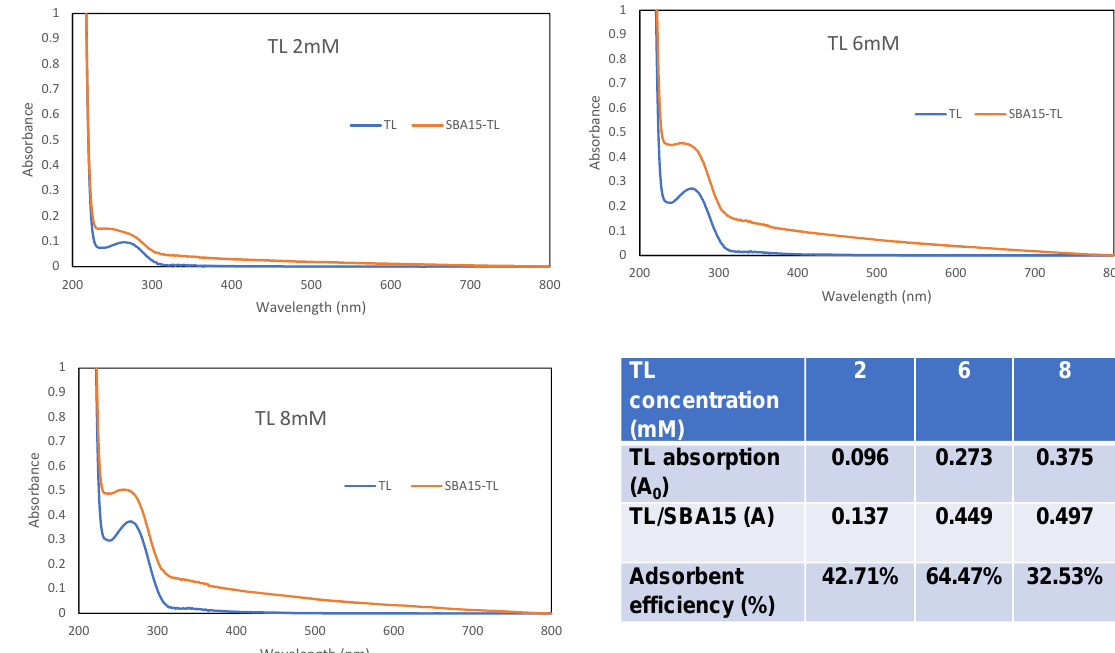
Figure 5. UV-vis analysis for different concentrations of TL before and after addition of SBA15.